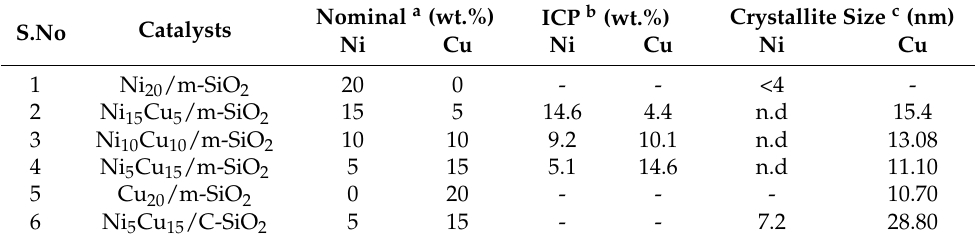
Table 1. Chemical and structural properties of Ni x Cu y /m-silica